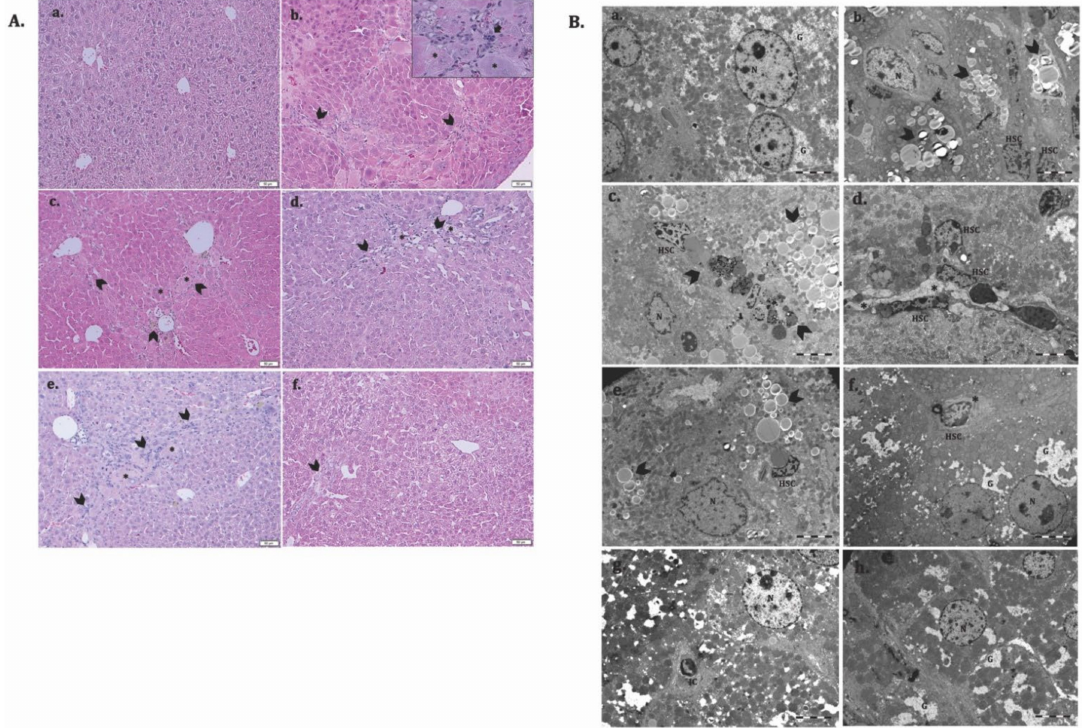
Figure 9. ADSC and HGF cotreatment improve the liver structure and ultrastructure of the fibrotic liver in diabetic mice. ( A ). Representative light microscopy micrographs of liver histology in H&E stain: (a) Control; (b) LF group—liver fibrosis in diabetic mice; (c) LFC group—self-recovery of liver fibrosis (positive control) in diabetic mice; (d) ADSC group—ADSC treatment of liver fibrosis in diabetic mice; (e) HGF group—HGF treatment of liver fibrosis in diabetic mice; (f) ADSC + HGF group—ADSC and HGF cotreatment of liver fibrosis in diabetic mice; scale bar: 50 µ m; fibrosis (arrow- head), foam hepatocyte (*), inflammatory infiltrate (arrow); ( B ). Representative electron microscopy micrographs of the liver for the experimental groups; (a) control, (b–d) LF group, (e) LFC group, (f) ADSC group, (g) HGF group, (h) ADSC + HGF group. N-hepatocyte’s nuclei; HSC—hepatocyte stellate cells; lipids (arrowhead); collagen (*); glycogen